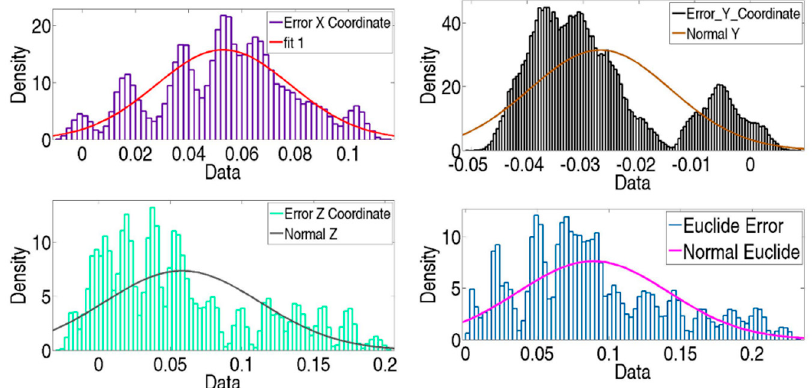
Figure 12. Initial error of MT verification points of 1000 tests.